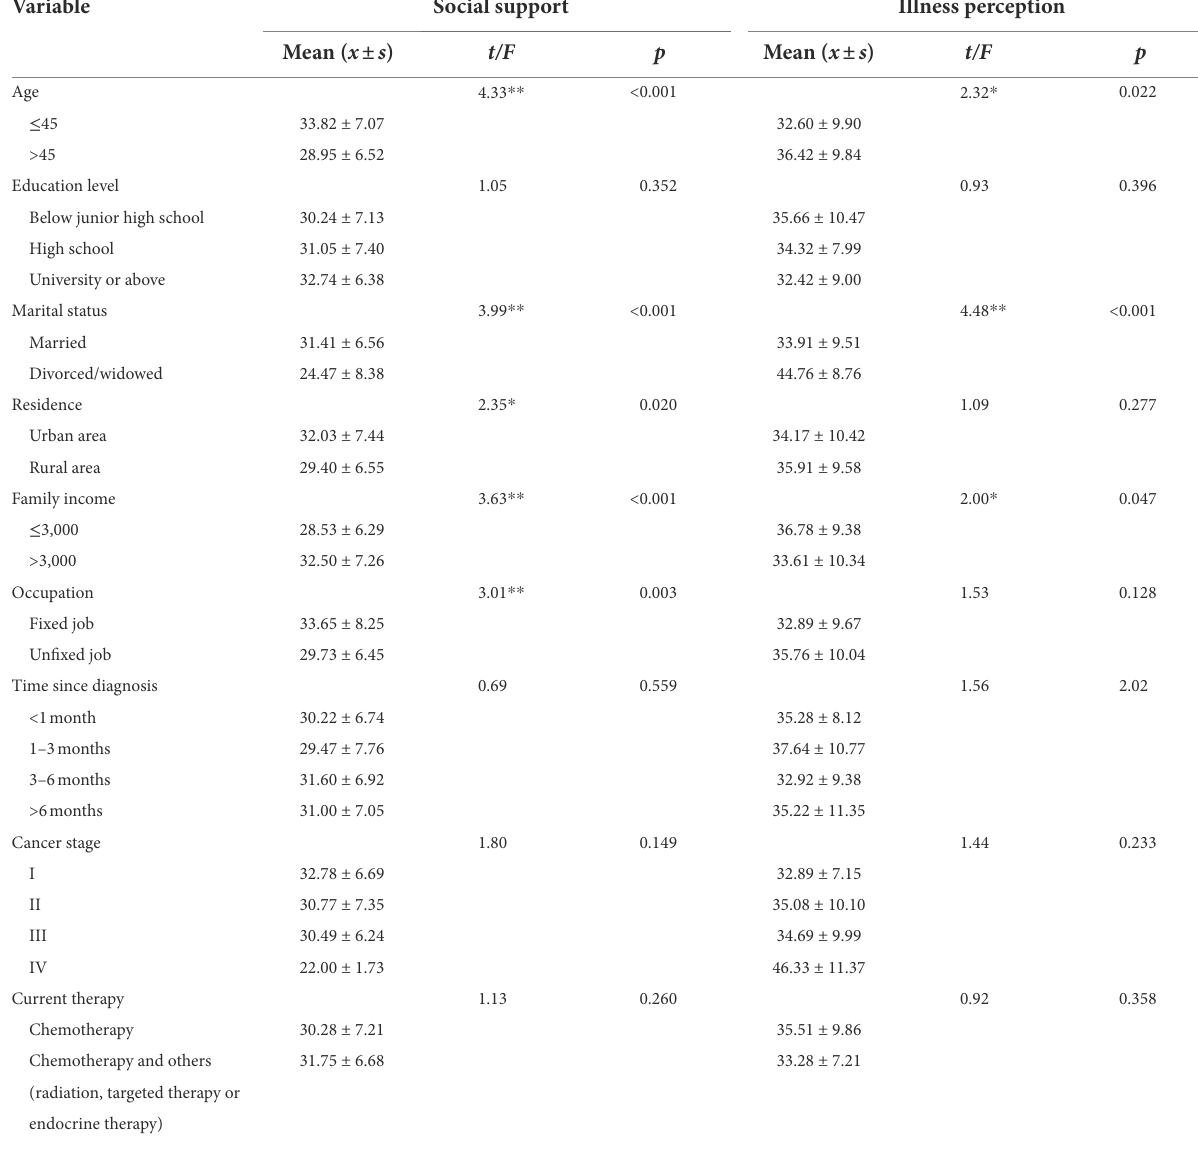
TABLE 2 The differences in social support and illness perception among different sample characteristics groups ( n = 157).